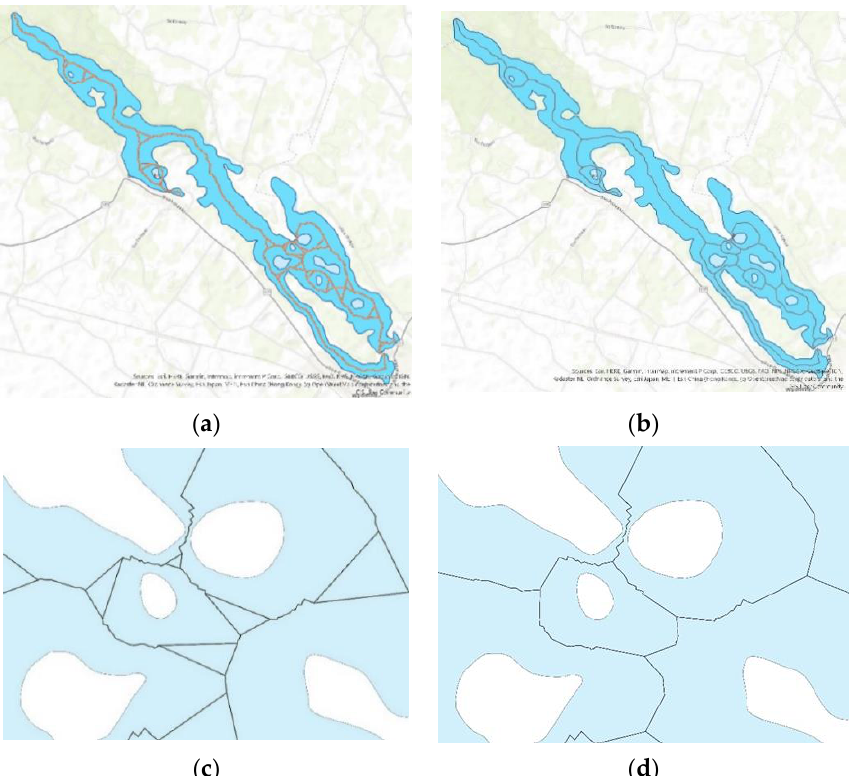
Figure 27. Skeleton model: ( a ) model with loops; ( b ) model where loops were replaced with loop centroids; ( c , d ) fragments of the skeleton before and after loop removal.